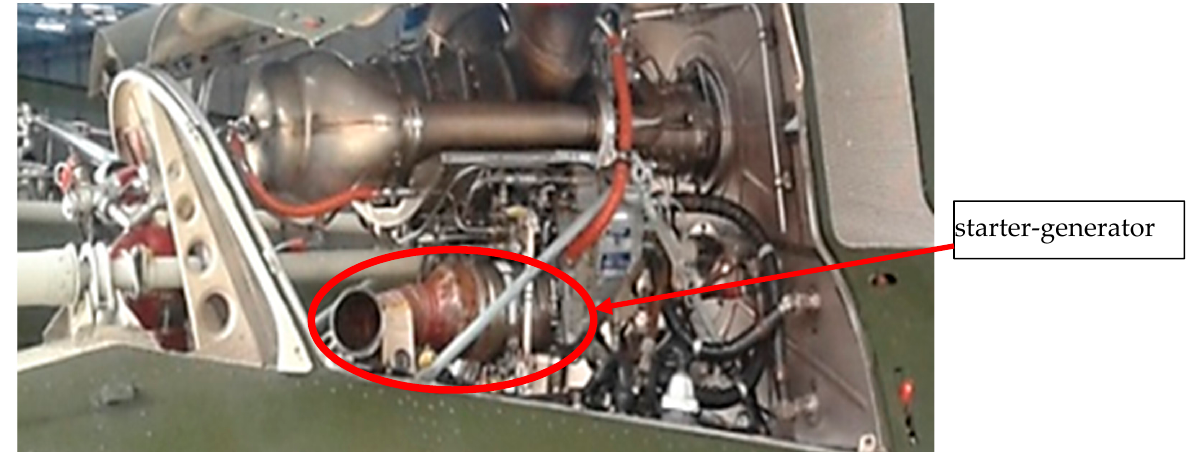
Figure 1. The installation place of the starter-generator on the